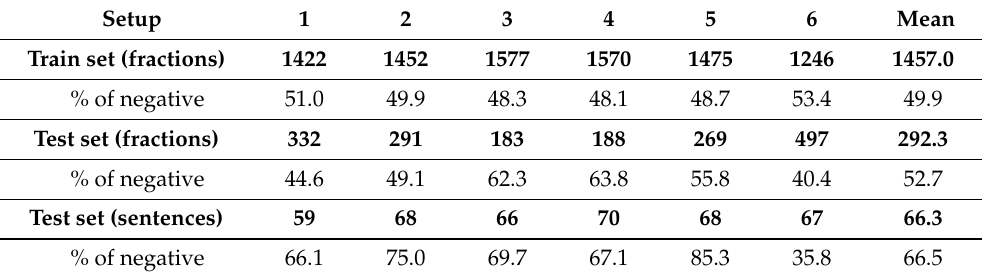
Table 8. Overview of train and test datasets in six